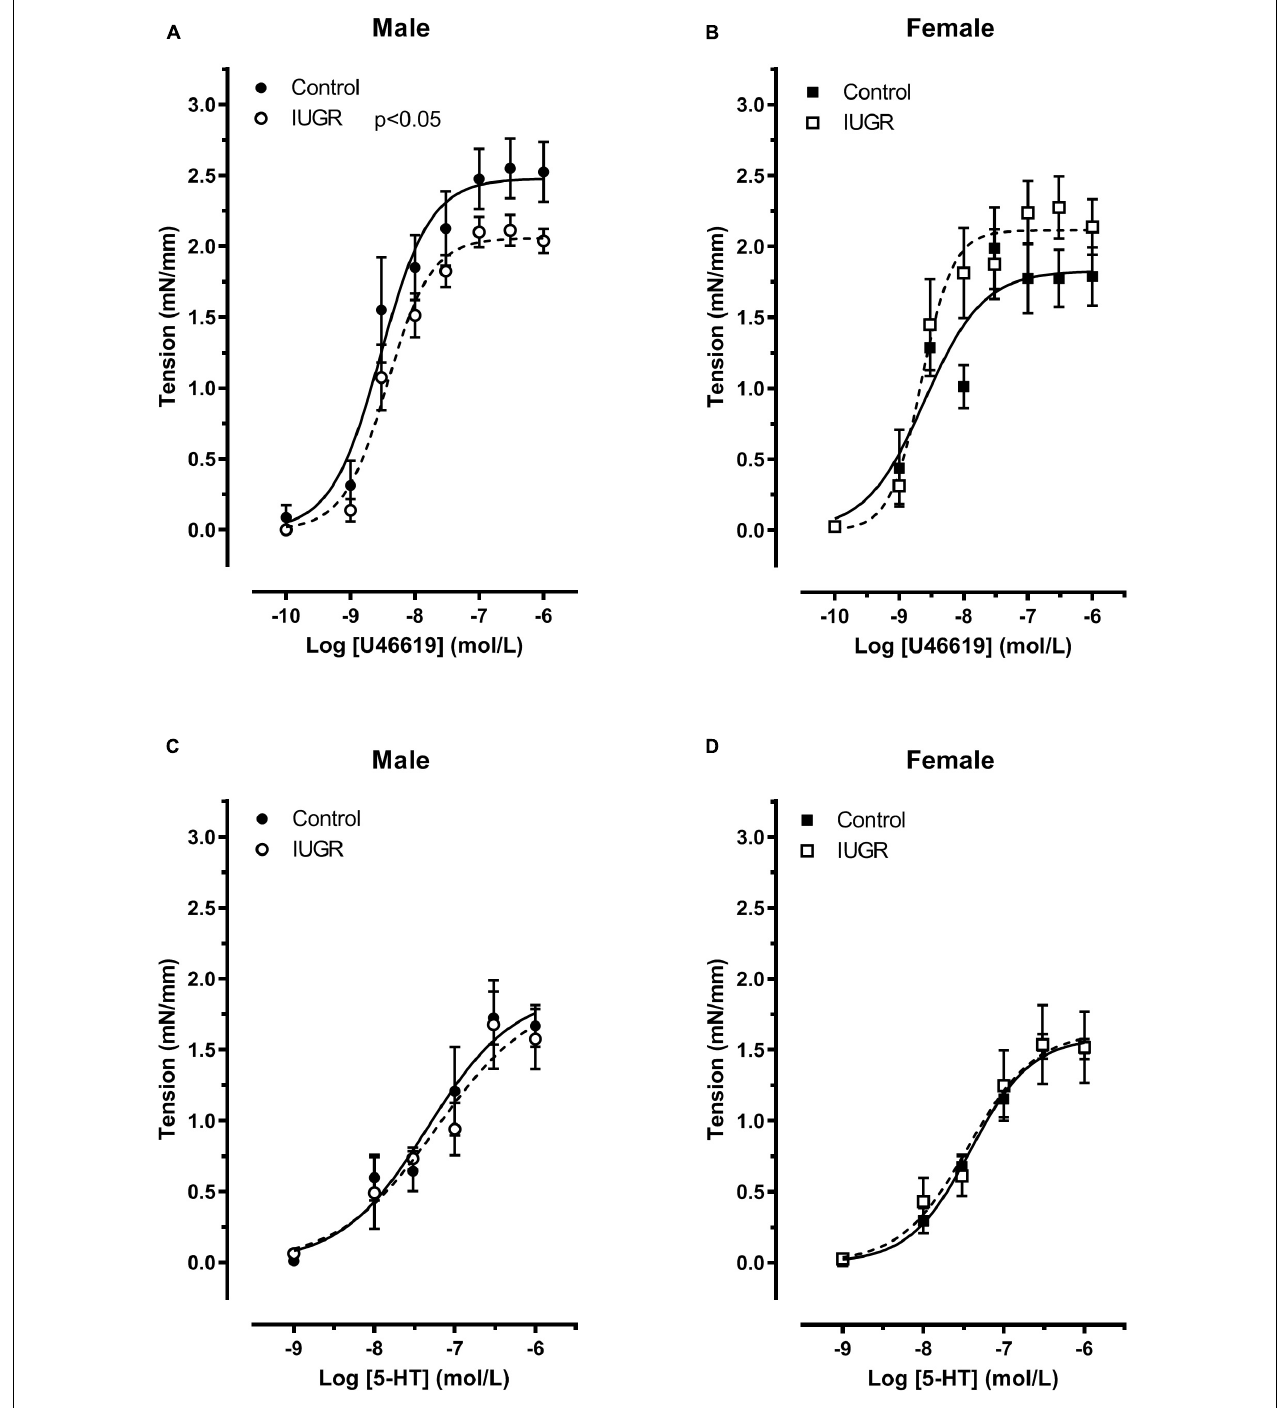
FIGURE 8 | Contractile responses to U46619 ( A,B , n = 8) and serotonin (5-HT) ( C,D , control n = 6, IUGR n = 5) in umbilical artery of control and IUGR fetuses. Each points is the mean ± SEM of n animals for each groups and sexes. The lines represents the best fit of all experimental points.